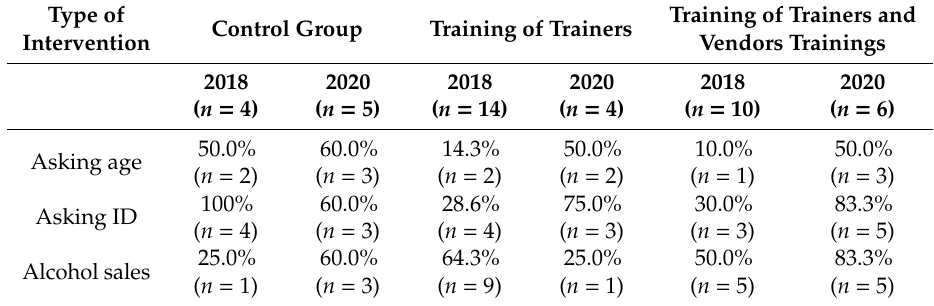
Table 1. Frequency of vendors’ compliance with age limitations for alcohol sales in supermarkets with younger minors (14–15 years old). Compliance was assessed through three indicators: whether cashiers ask for age and / or ID card, and alcohol sales to